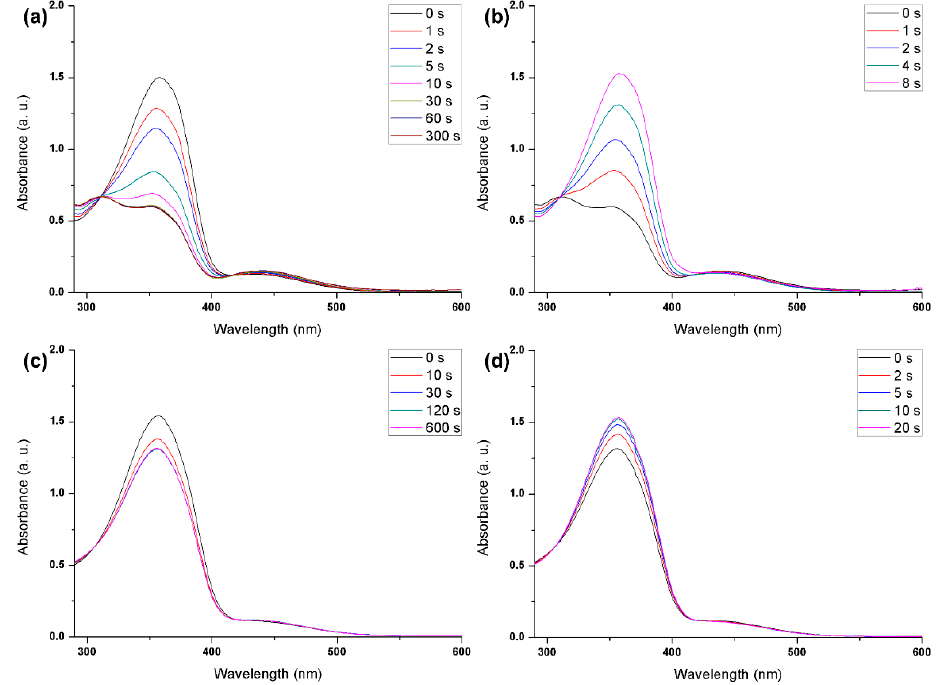
Figure 4. UV-vis absorption spectral changes of DRBCP1b ( a,b ) in THF solution and ( c,d ) in aqueous solution. Irradiation of ( a,c ) UV light and ( b,d ) visible light subsequently were conducted.